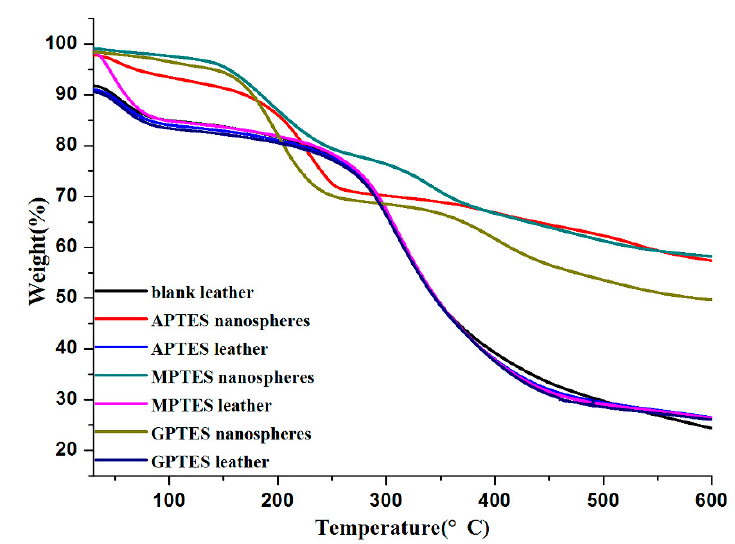
Figure 5. Thermogravimetric analysis of modified SiO 2 nanospheres and non-crosslinker-modified SiO 2 nanosphere leather. Table 2. Weight gain and adsorption capacity of SiO 2 nanospheres leather without a cross-linking agent.